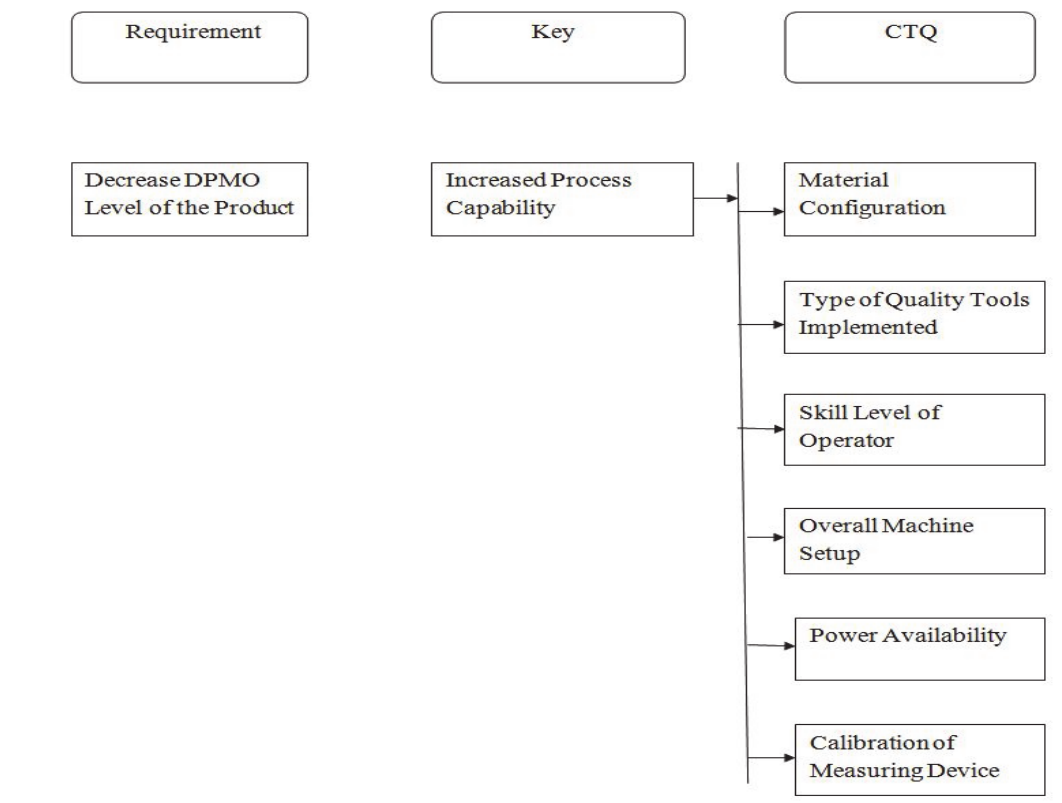
Fig. 4. Tree Diagram for CTQ Factors Regarding Shoulder Bolt